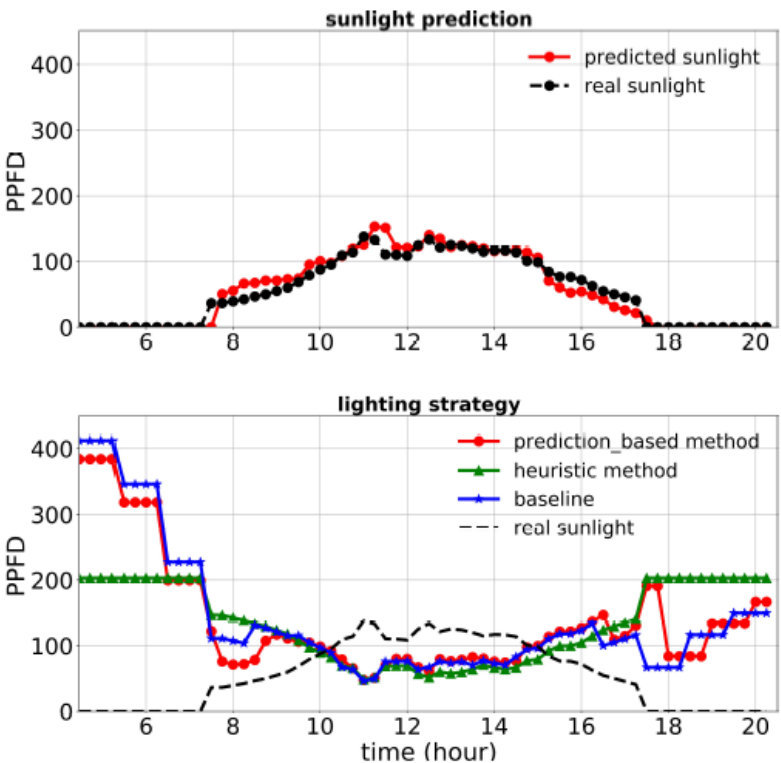
Figure 8. Sunlight prediction models and lighting strategies for the predictive light control systems [11]. PPFD was measured with units of µmoL m − 2 s − 1 .